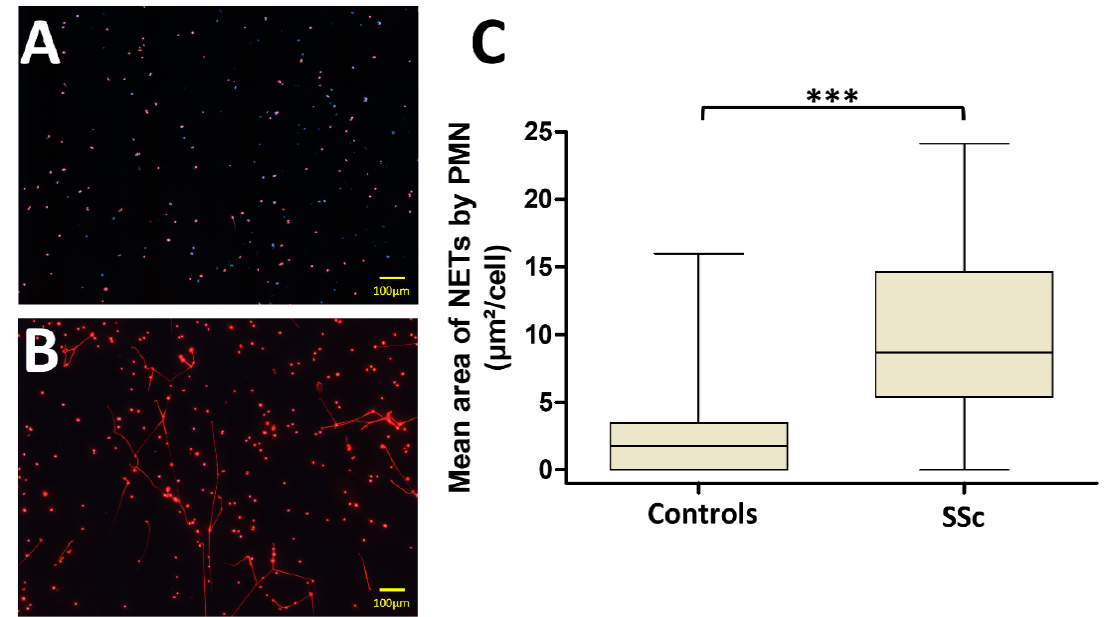
Figure 1. Polymorphonuclear neutrophils (PMN) from systemic sclerosis (SSc) patients generated more neutrophil extracellular traps (NETs) than those from the controls. PMN from SSc patients and controls were stimulated in autologous conditions. ( A ) The most representative pictures (Sytox Orange and Hoechst 33342, 16 consecutives pictures with X20 magnification) of PMN from one control. ( B ) The most representative pictures of PMN from one SSc patient. ( C ) The median areas of NETs were statistically higher in SSc patients than in the controls (n = 34 for the SSc group and n = 26 for the control group). All stimulations were performed in duplicate. The mean area of NETs released by PMN is represented by a “box and whiskers” plot for each condition tested. Boxes show the 25–75th percentiles, lines show the median value, and whiskers show the range of the mean area of NETs released by PMN. *** p < 0.001.